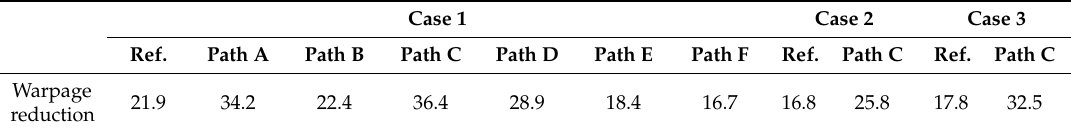
Table 3. Warpage reduction (%) of point DS1 for different building strategies compared to the original reference (100%).